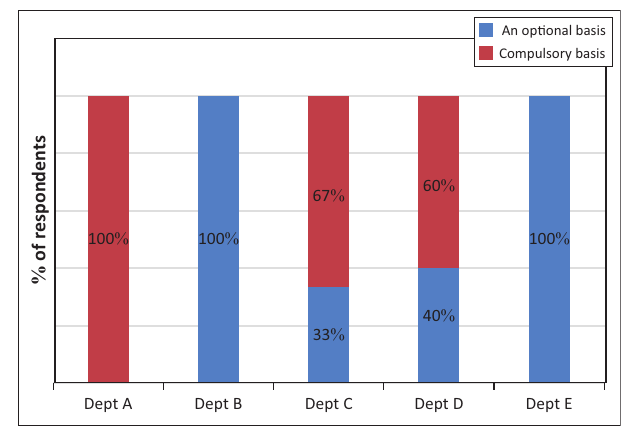
FIGURE 11: Utilisation of Online Research Output Submission